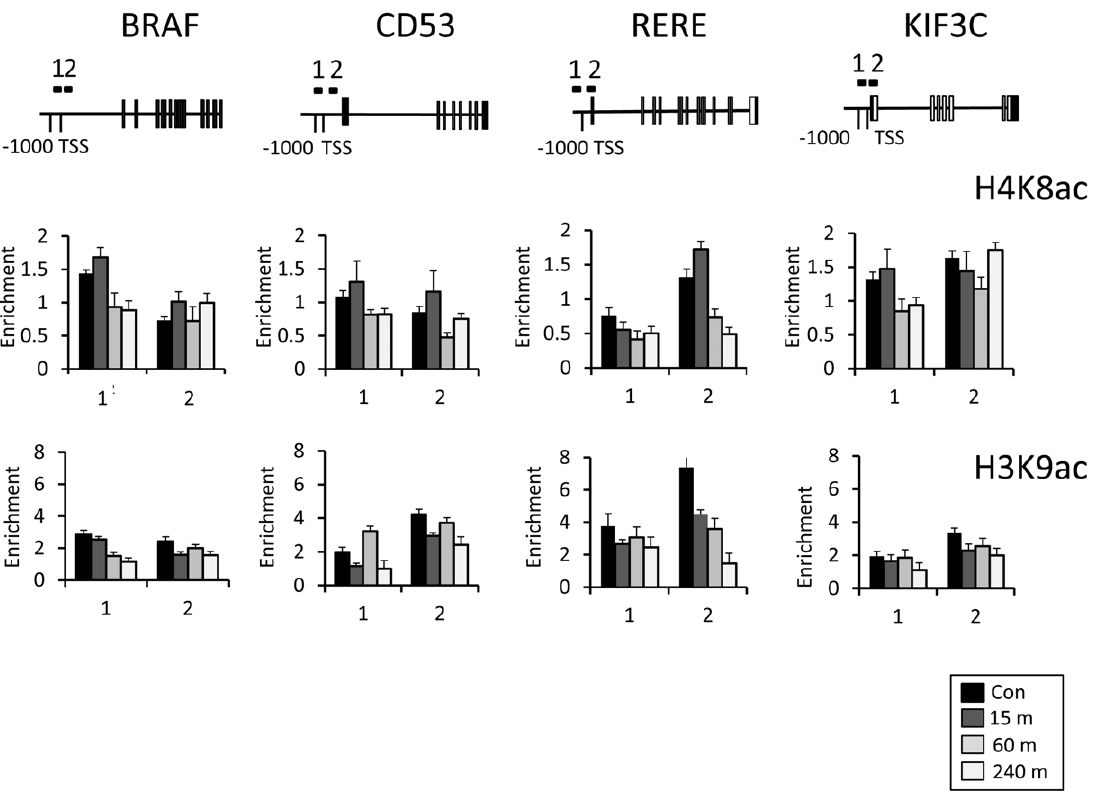
Figure 4. Histone acetylation changes on up-regulated genes during extended VPA treatment. Chromatin-immunoprecipitation analysis of H4K8ac and H3K9ac on up-regulated genes ( BRAF, CD53, RERE, KIF3C ) in response to VPA treatment (5 mM). Analysis was performed on either untreated cells (Control) , or during VPA treatment (15, 60 & 240 minutes) . Primer locations are indicated on the gene diagrams. The abundance of a histone modification (‘ Enrichment ’) is calculated from the ratio of material detected in bound:unbound